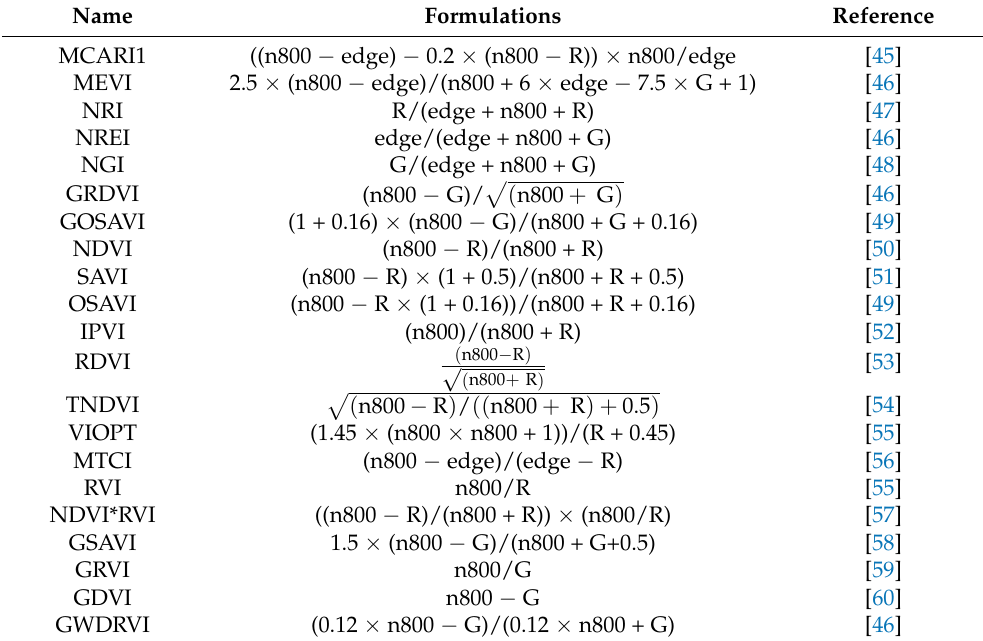
Table 2. The commonly applied multispectral-based vegetation indices. B, G, R, edge, and n800 each represented blue, green, red, red edge, and near infrared bands of the Mini MCA 6